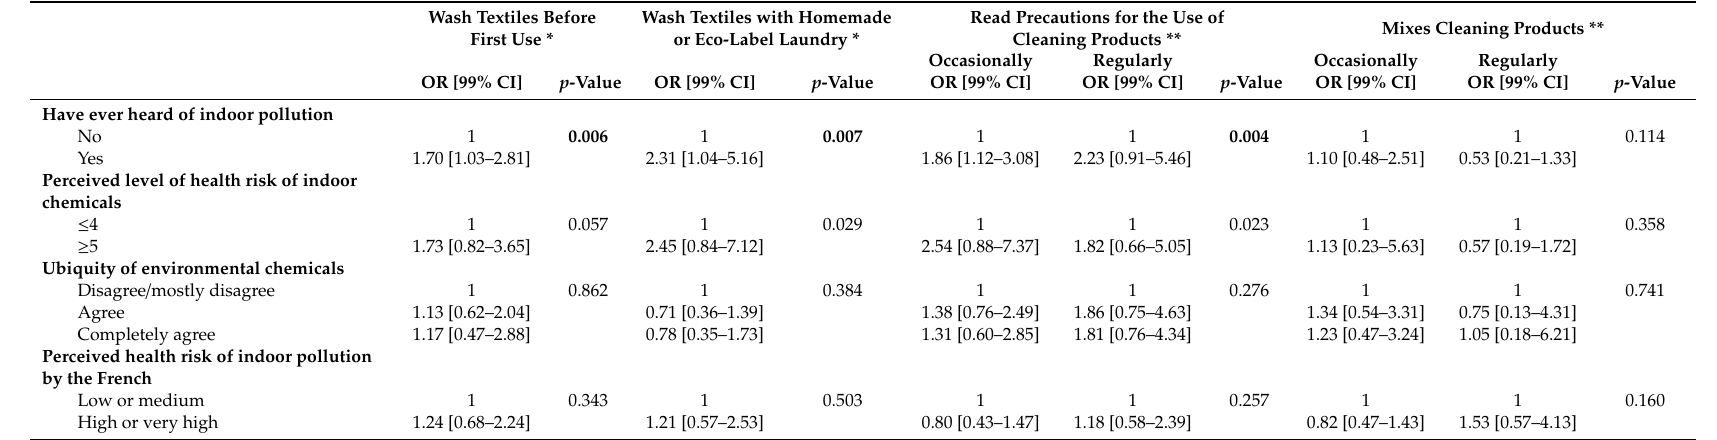
Table 5. Practices concerning textiles and housekeeping according to the level of awareness /